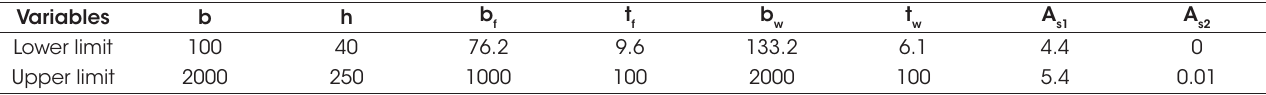
Table 2 Limit parameter for design variables (dimensions in mm and area in cm 2 )